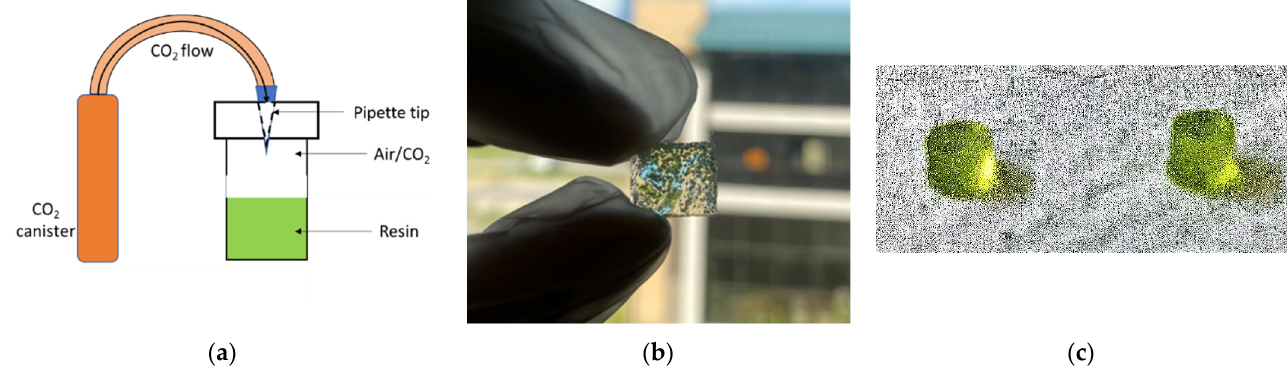
Figure 2. ( a ) Illustration of lab-made carbonation setup, ( b ) Image of a 3D-printed carbonated polymer coupon, and ( c ) Image of some printed samples for testing.